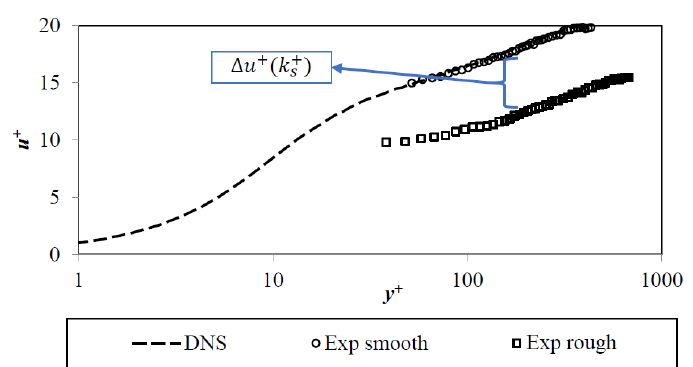
Figure 2. Universal velocity distribution u + = f ( y + , k + s ) in a boundary layer with roughness effects. The figure is taken from Juckelandt et al.